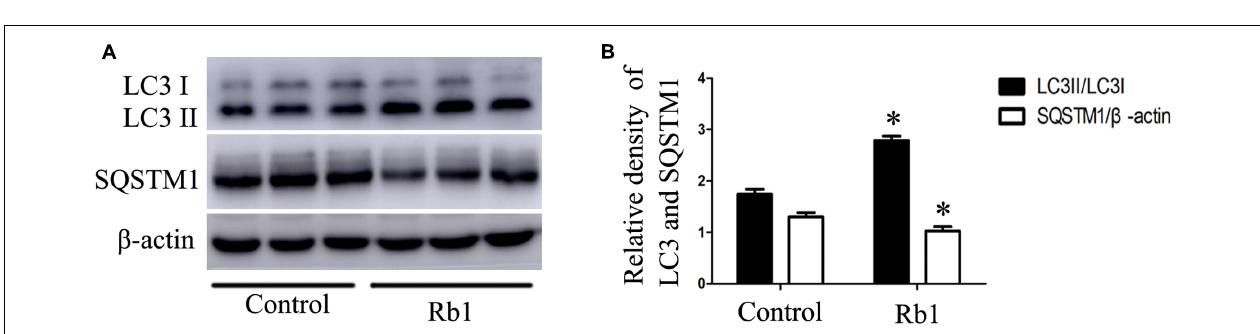
FIGURE 4 | Effect of Rb1 treatment on plaque stability of apoE − / − mice. (A) Immunohistochemical staining of oil red O staining (lipids), MOMA-2 (macrophages), α -SMA (smooth muscle cells) and sirius red staining for the quantification of collagen. (B) Area measurement of plaque components. Scale bar: 100 µ m. ∗ p < 0.05, compared to the control group, n = 6.